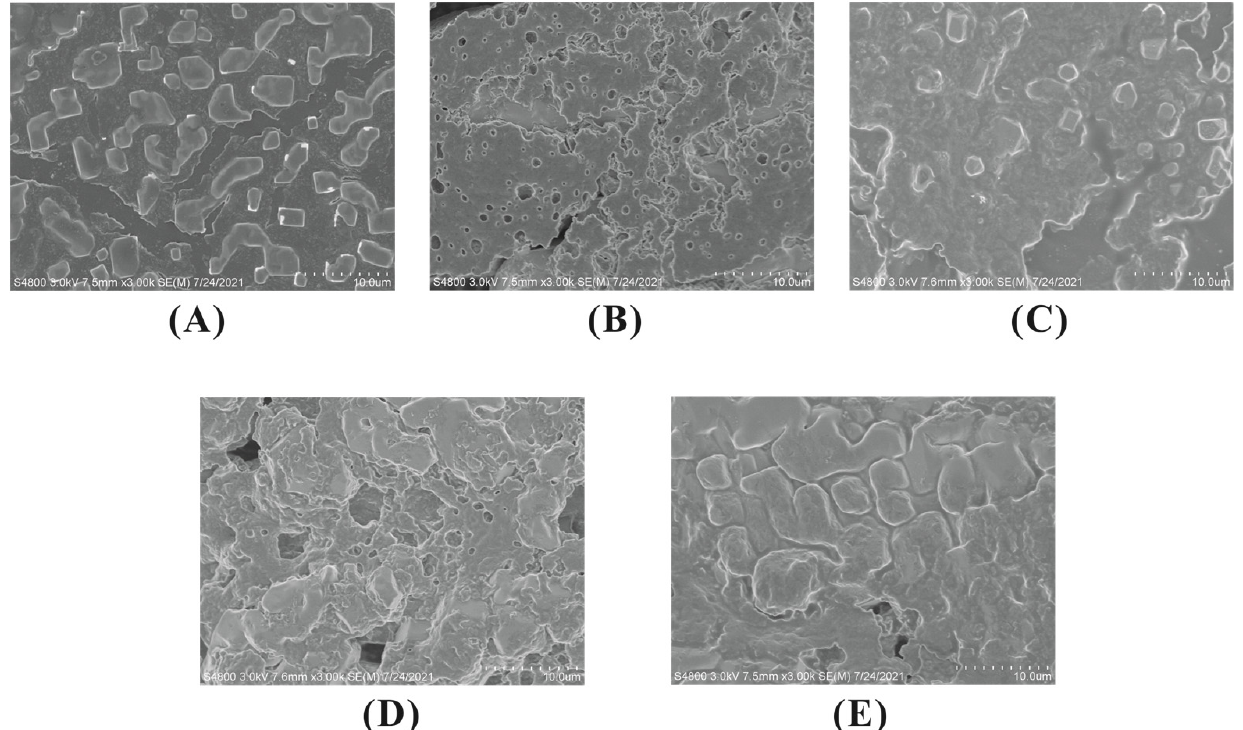
Figure 6. SEM micrographs of WPI (Magnification 1: 3000) in fish oil-fortified emulsions incubated at 25 °C for 24 h in the absence or presence of EC (0.1~2 mM). ( A ) WPI control; ( B ) WPI + fish oil; ( C ) WPI + fish oil + EC 0.1 mM; ( D ) WPI + fish oil + EC 1 mM; ( E ) WPI + fish oil + EC 2 mM .